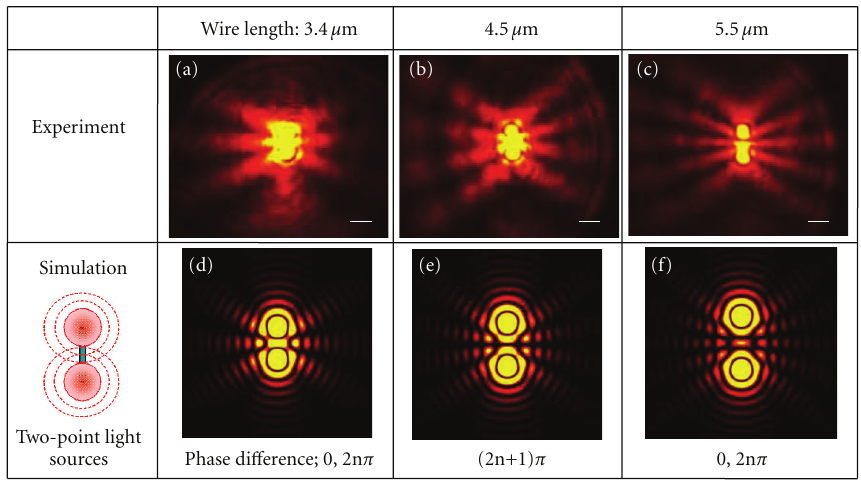
Table 1: Far-field optical images of lasing emissions from single GaAs/GaAsP core-shell nanowires. (a)–(c) Observed lasing emissions from di ff erent nanowires with lengths of 3.4, 4.5, and 5.5 μ m. Incident laser spot is focused perpendicularly at center of nanowires. Scale bars: 5 μ m. (d)–(f) Simulated interference patterns for corresponding nanowires in panels (a)–(c), assuming spherical nondirectional emissions from wire end facets